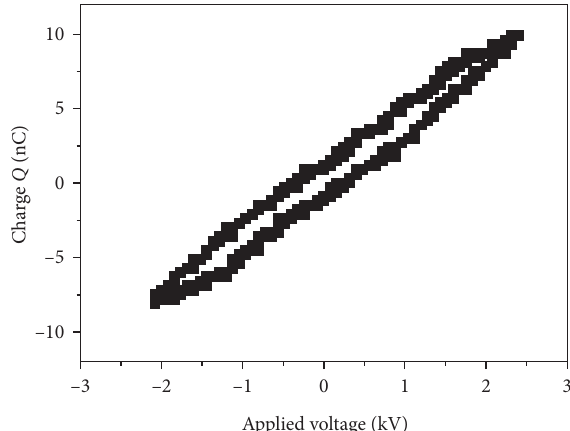
Figure 4: Typical Lissajous Q-U figures of the double dielectric barrier discharge.